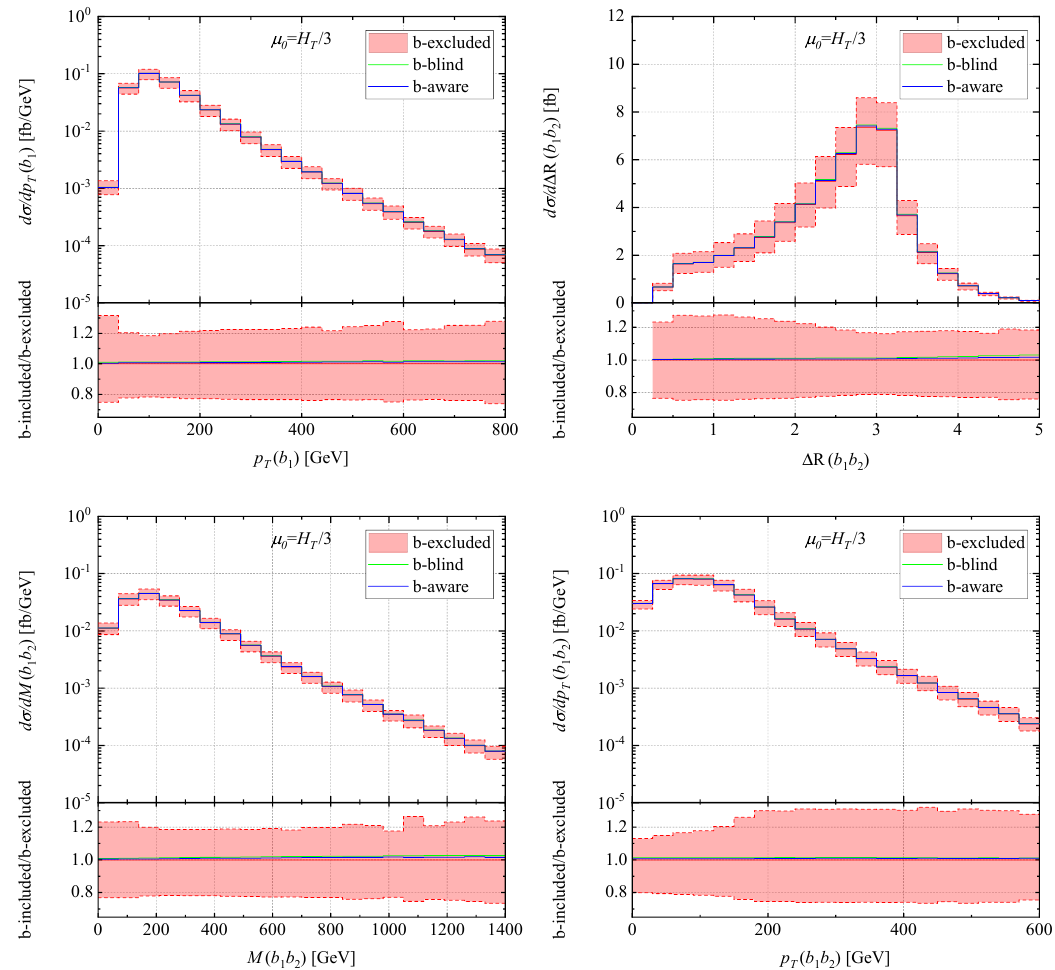
Figure 11 . Differential cross section distributions as a function of p T ( b 1 ) , ∆ R ( b 1 b 2 ) , M ( b 1 b 2 ) and p T ( b 1 b 2 ) for the pp → e + ν e µ − ¯ ν µ b ¯ b b ¯ b + X production process at the LHC with upper plots show absolute NLO QCD predictions without and with the initial state bottom quark contributions. In the latter case results are shown for the charge blind and charge aware b -jet tagging. The lower panels display the differential ratios of these contributions. Also shown is the NLO scale dependence for the case without the initial state bottom quark contributions. The NLO NNPDF3.1 PDF set is employed and µ 0 = H T / 3 is